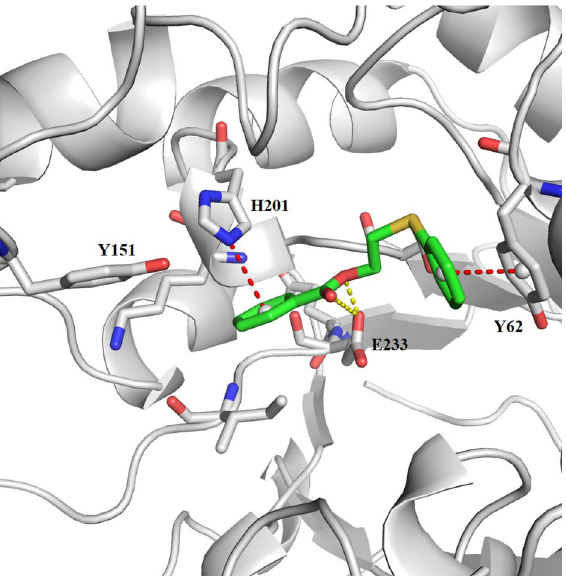
Figure 8. Docking solution of the compound 2a inside the binding pocket of α-amylase (pdb code: 4w93) forming hydrogen bonds with the residue E233 and charge–π interactions with H201.